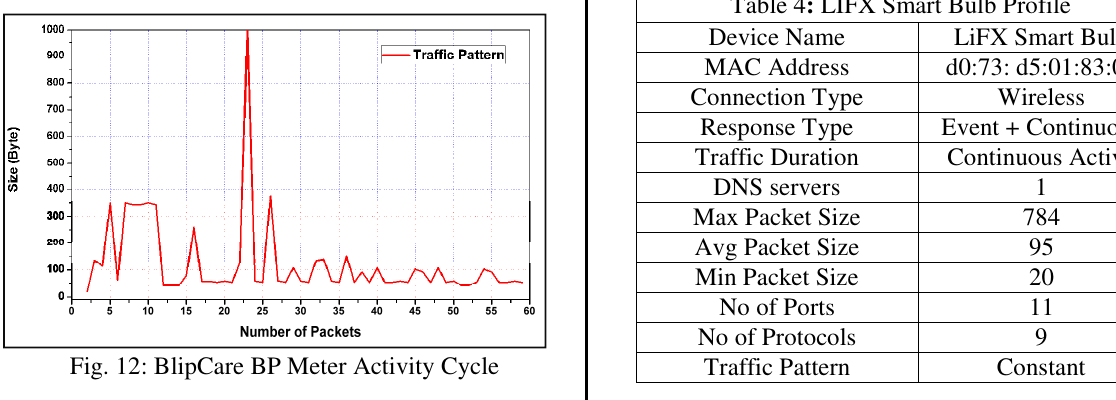
Table 4 : LIFX Smart Bulb